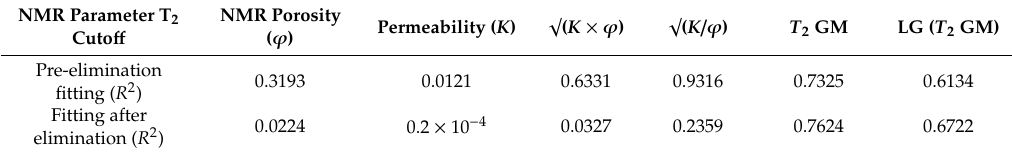
Table 3. The correlation between NMR experimental parameter and T 2 cuto ff